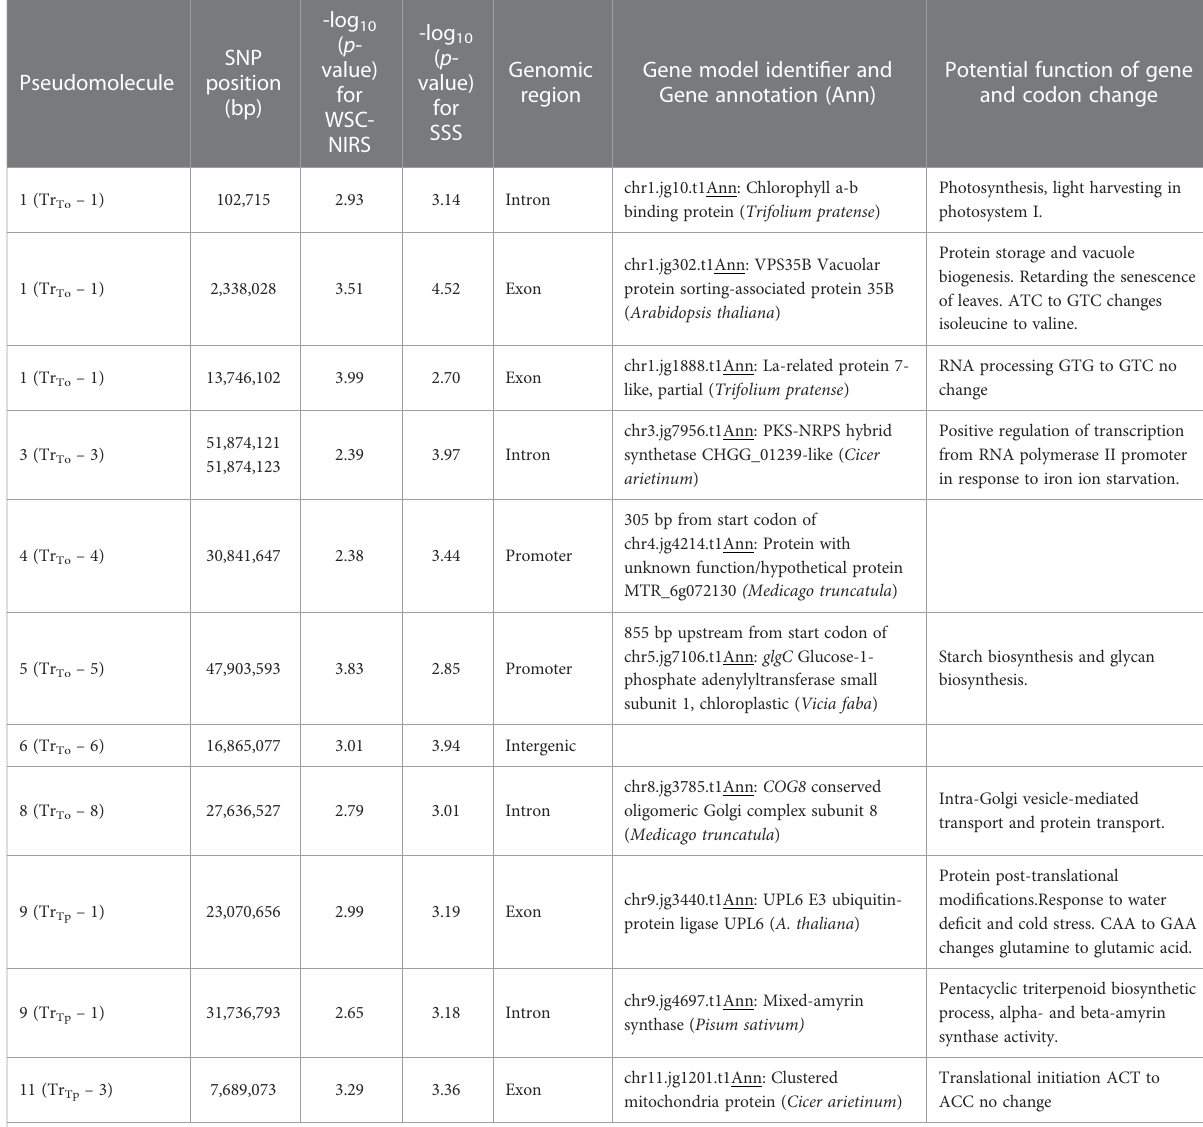
TABLE 2 Genome position and gene annotation for SNPs with large -log 10 ( p -values) identi fi ed from a genome-wide association study (GWAS).